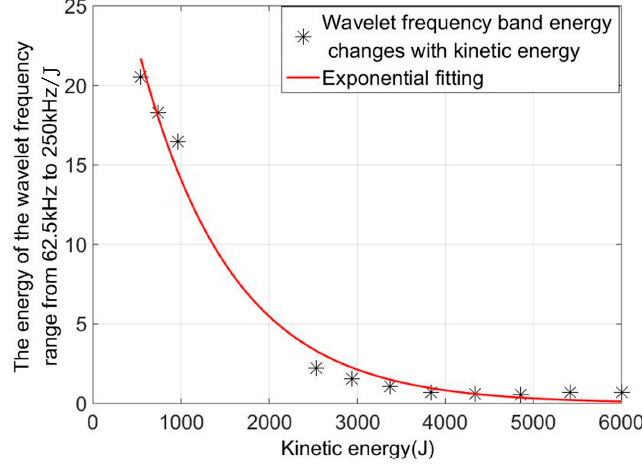
Figure 7. Wavelet frequency band energy value with kinetic energy change.